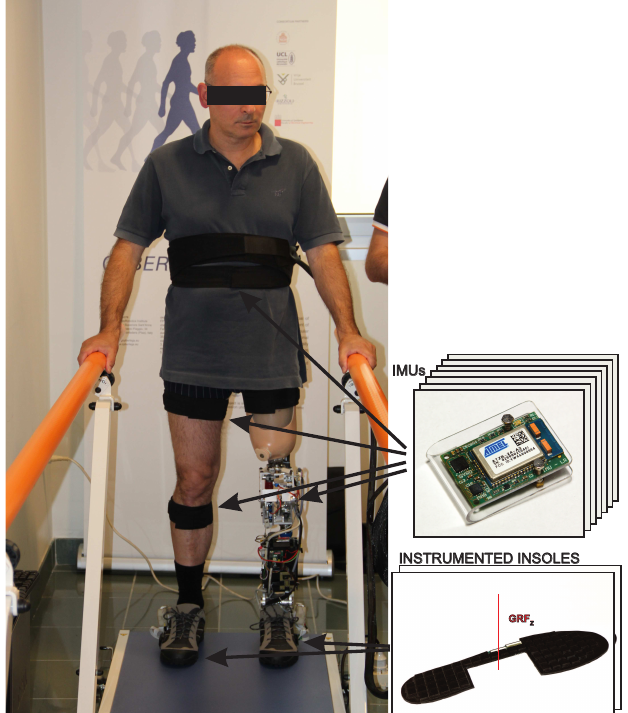
Figure 2. The experimental setup: the amputee is walking between parallel bars with a robotic prosthesis and wearing wearable